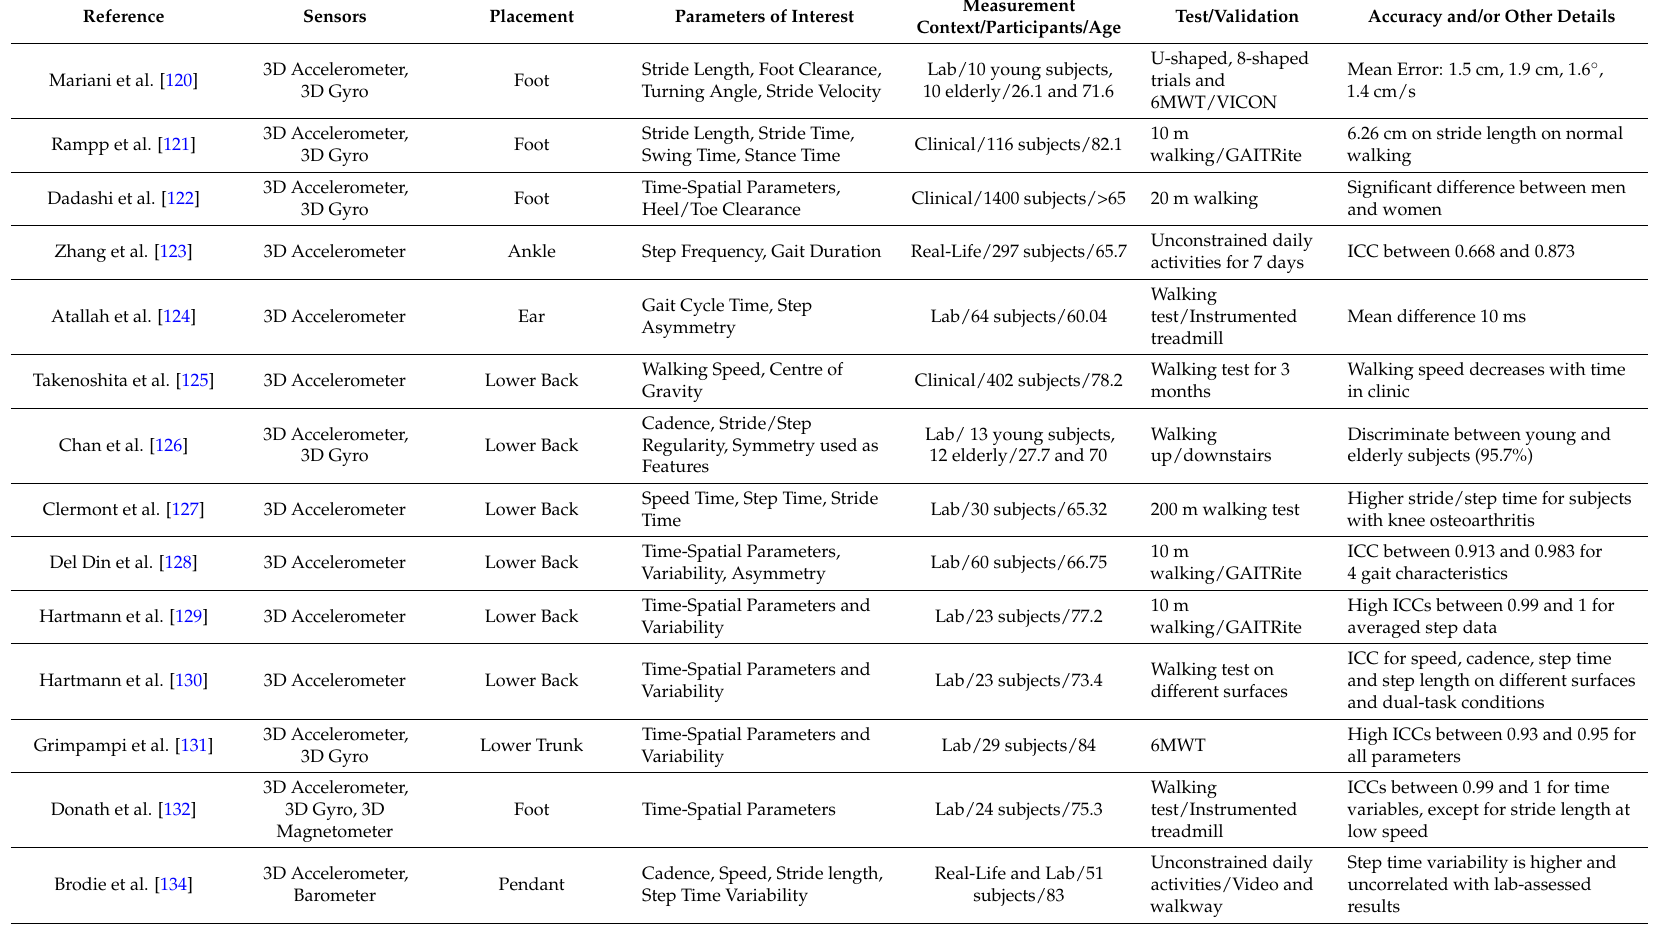
Table 3. Gait Analysis Systems for Senior